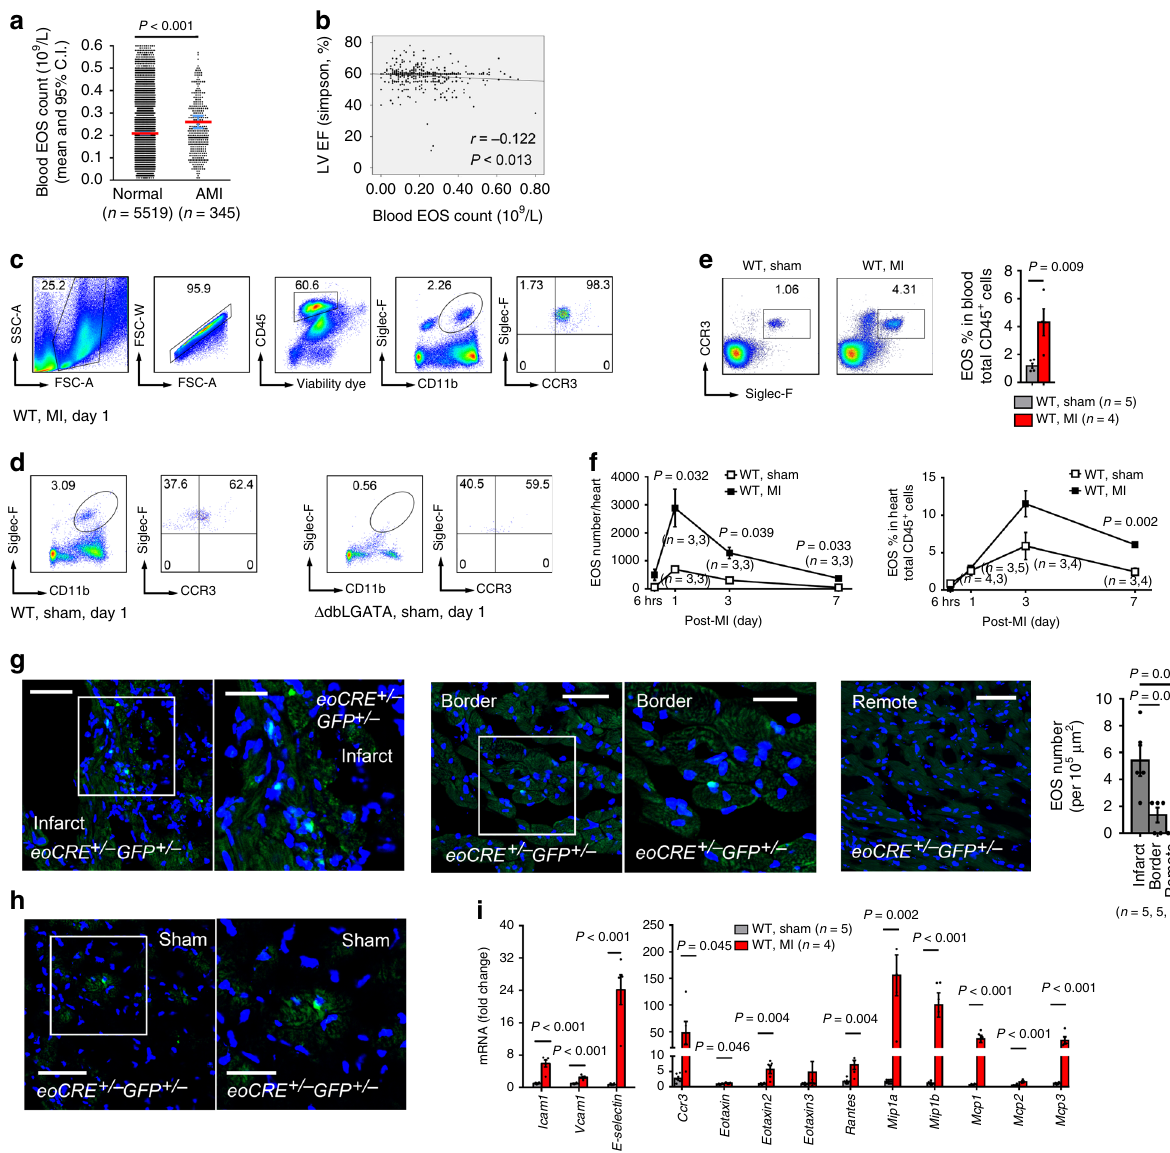
Fig. 1 Increased human and mouse blood and heart EOS count after MI. a EOS count per liter blood in men with ( n = 345) and without ( n = 5,519) AMI ( P = 3.3 x 10E-9). b . Spearman correlation between LV EF and blood EOS count among a subgroup of 482 men who had the echocardiography results available ( r = − 0.122, P = 0.013). c . FACS strategy to analyze heart and blood EOS from WT mice at 1-day post-MI. d Representative FACS images of heart EOS from WT sham at 1-day after operation. EOS-de fi cient Δ dblGATA sham mice served as negative control. e FACS analysis of blood EOS in WT sham and MI mice at 1-day after surgery. Representative FACS images are shown to the left. f . FACS analysis determined heart EOS count or percentage among total CD45 + cells in WT MI and sham mice at different days after surgery. g , h Anti-mouse GFP antibody detection of GFP-positive EOS in the infarct, border, and remote regions from eoCRE + / − GFP + / − mice at 1-day post-MI. Representative images are shown to the left ( g ). Heart sections from sham- operated eoCRE + / − GFP + / − mice served as experimental control ( h ). Scale: 30 µ m, inset: 15 µ m. i . RT-PCR determined the mRNA levels of EOS relevant chemokines in heart tissues from WT MI and sham mice at 1-day after surgery. Data are mean ± SEM. The numbers of patients ( a ) and mice ( e – g , i ) in each group, and P values ( a , e – g , i ) are indicated, Student ’ s t-test ( a ), non-parametric Mann-Whitney U test followed by Bonferroni correction ( e , f , i ), and one-way ANOVA test ( g